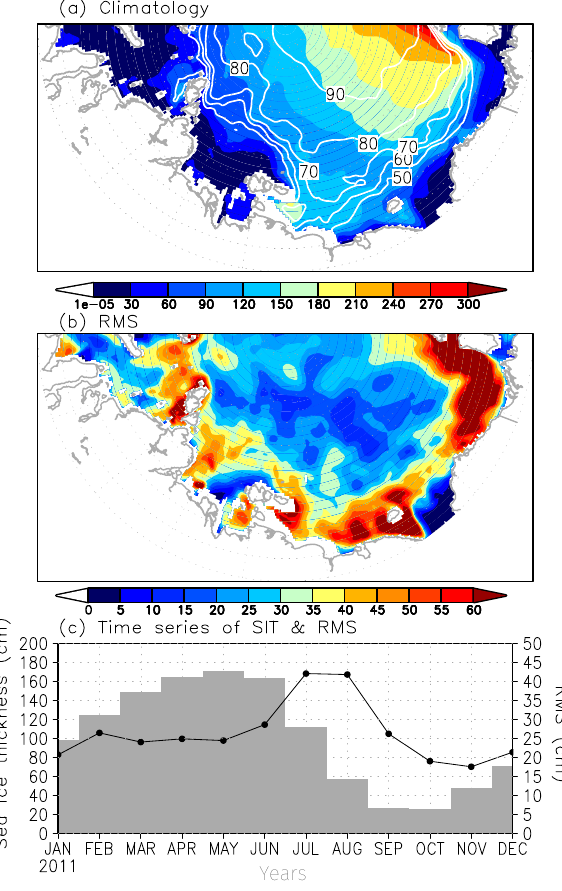
Figure 5. Spatial distribution of (a) monthly mean (colours) cli- matological SIT (m) in the TOPAZ4 reanalysis and (b) the rms variability of daily mean SIT (colours) in July during 2011–2014. The monthly mean of climatological SIC (white contours) in July is indicated in panel (a) . The rectangular region enclosing the ESS (70–80 ◦ N, 150–180 ◦ E) is shown in panel (b) . (c) Time series of monthly mean SIT (grey shading) and rms of TOPAZ4 reanalysis (black line) averaged over the ESS. The scale of the rms is indi- cated on the right axis.